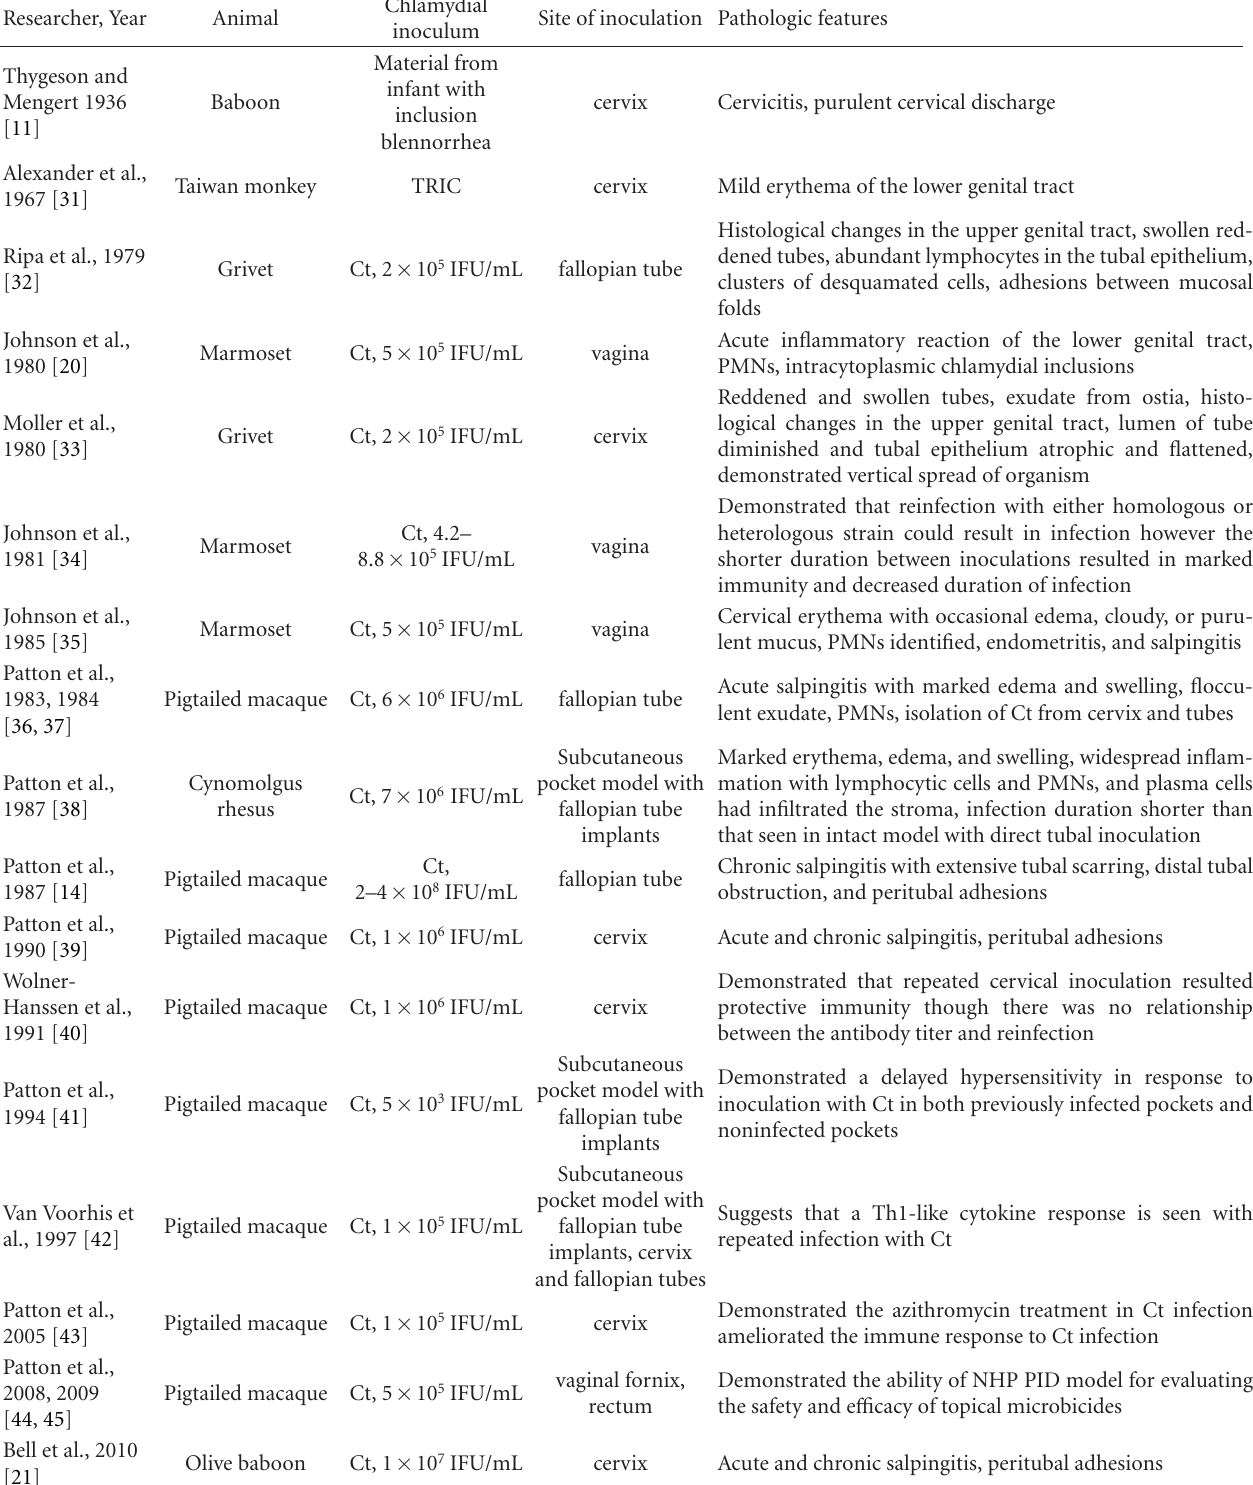
Table 2: Historical NHP PID models and the pathological features found with each subsequent